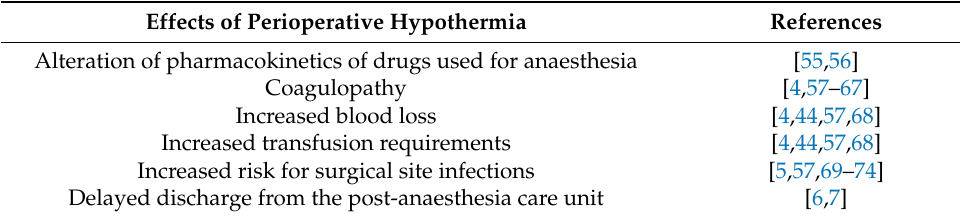
Table 2. Main consequences of perioperative hypothermia. Effects of Perioperative